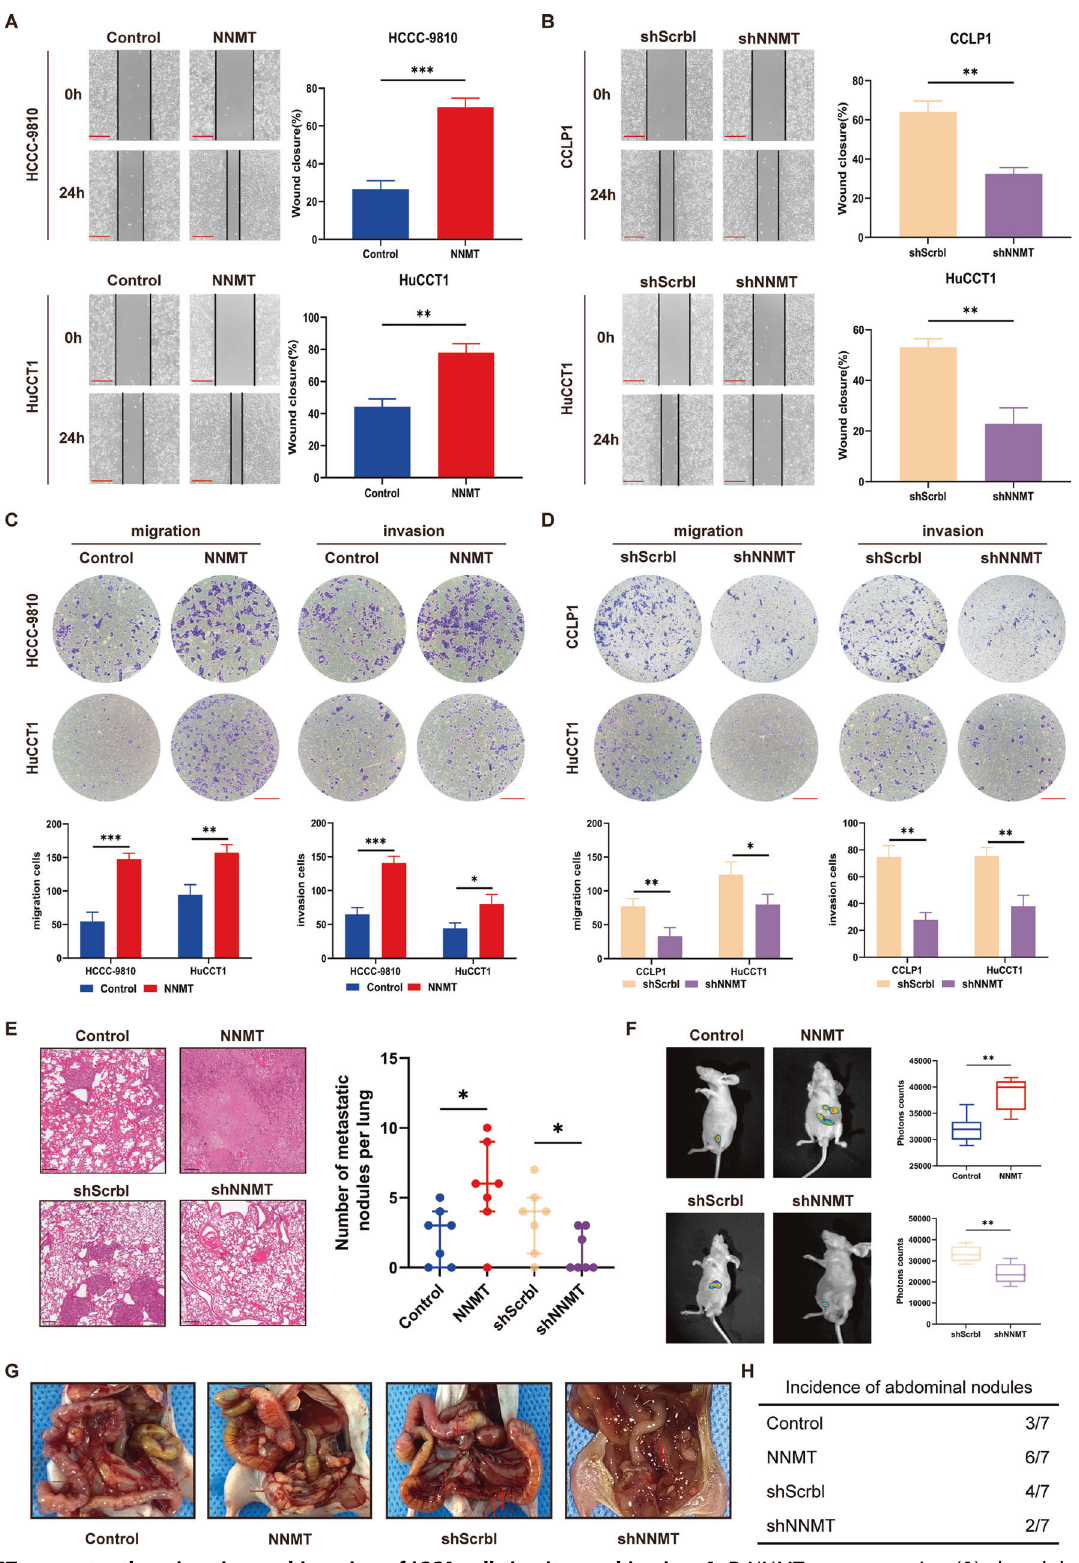
Fig. 3 NNMT promotes the migration and invasion of iCCA cells in vitro and in vivo. A , B NNMT-overexpressing ( A ), -knockdown ( B ), and control cell lines were used in wound-healing experiments. Scale bars: 100 μ m ( n = 3). C , D Transwell experiments veri fi ed the migration and invasion of cells overexpressing ( C ) or knockdown ( D ) NNMT, as well as the control cell lines. Scale bars: 100 μ m ( n = 3). E Representative images of H&E staining in lung metastases (left panel) and the number of metastatic nodules per lung (right panel) ( n = 7). F , G Representative images of the tumor nodules in peritoneal metastasis experiments ( n = 7). H The number of nude mice with metastatic nodules in each group (data are mean ± SEM, * P < 0.05, ** P < 0.01, *** P <